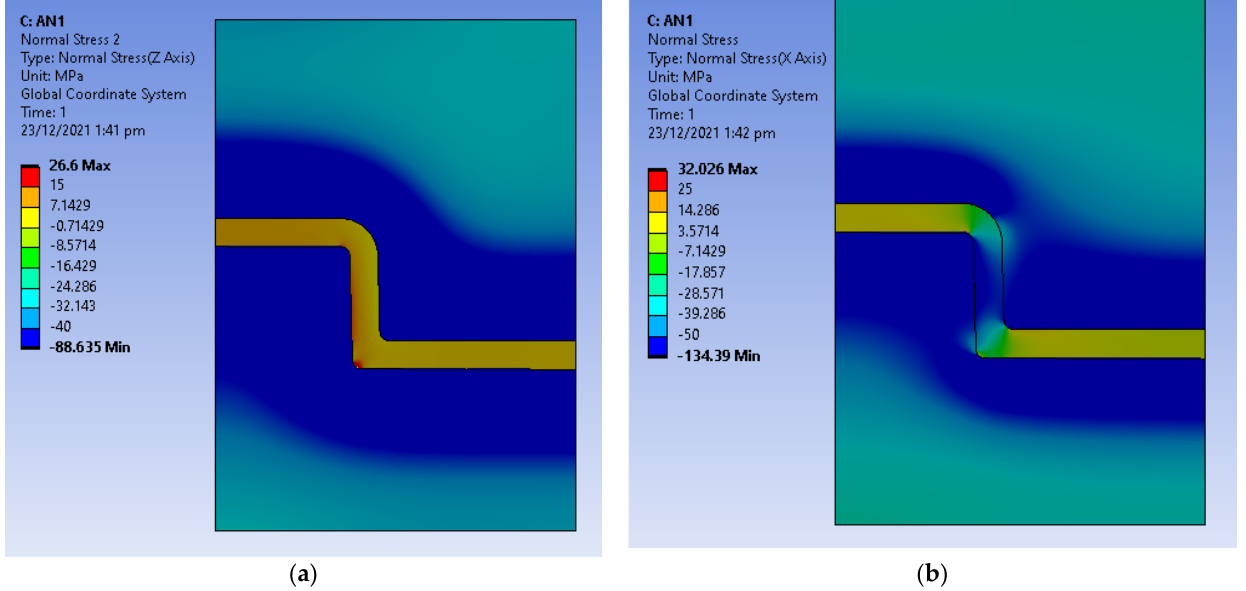
Figure 13. ( a ) Hoop stress at the end of the cooling stage; ( b ) Radial stress at the end of cooling stage.